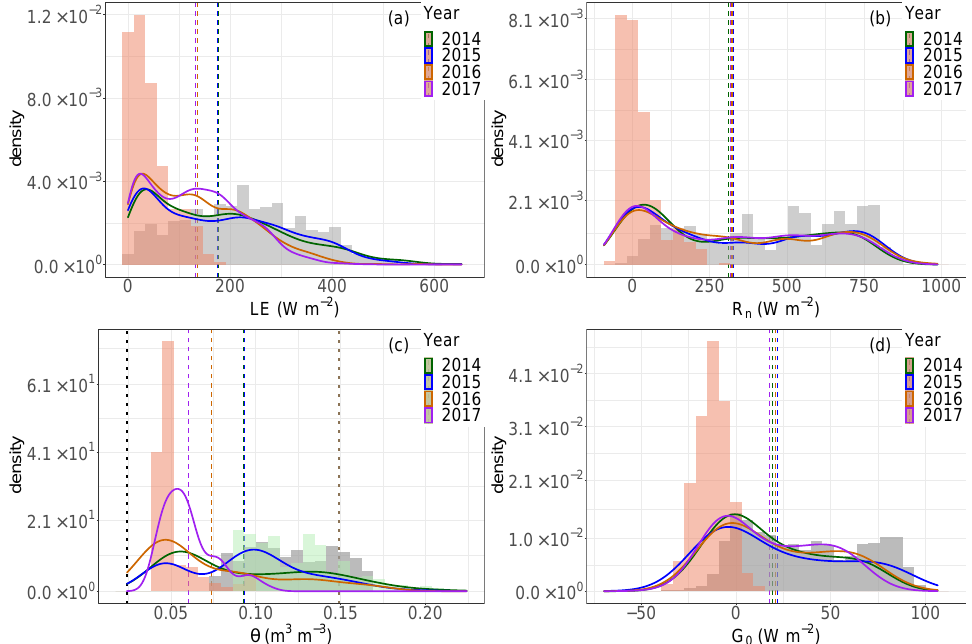
Figure 7. Frequency density distributions (in every growing season, JJAS) for: ( a ) Latent heat flux ( LE ). ( b ) Net radiation ( R n ). ( c ) Shallow volumetric soil water content ( θ , at 10-20 cm of soil depth). ( d ) Surface ground heat flux ( G 0 ). Dashed lines represent the mean values for each variable in each growing season. Based on 2015 data as an example, light red histograms represent the density distribution of LE and R n between 05:00 and 7:00 and between 17:00 and 20:00. The grey histograms refer to the hours between 08:00 and 16:00. For soil water content, the light red histogram refers to the dry period (DOY 185–223). The grey and green histograms are instead related to the wet periods (DOY 164–184 and 224–253, respectively). The dotted lines represent the soil water content at wilting point (black) and at field capacity